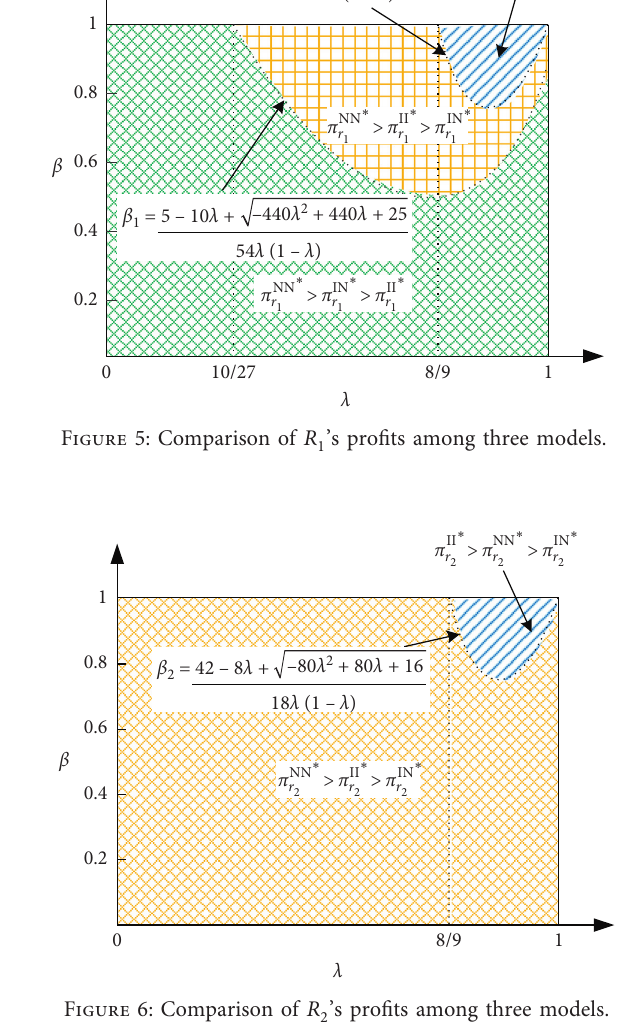
’s profits among three 2